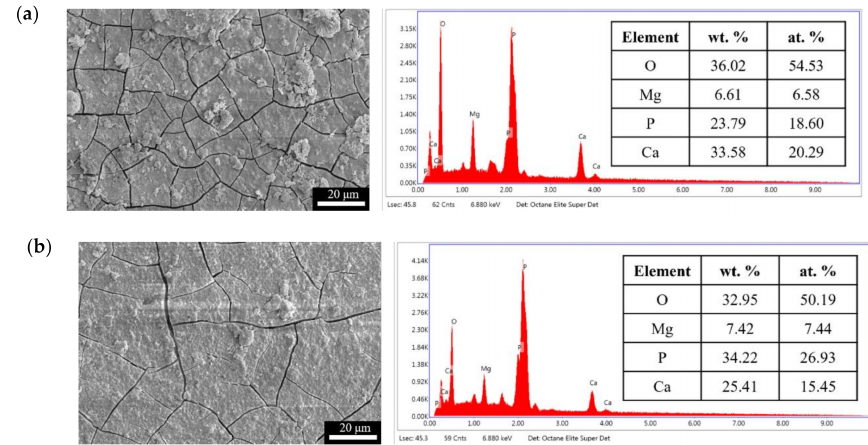
Figure 11. Surface morphologies and EDS spectra of ( a ) F and ( b ) FP after immersed in SBF for 28